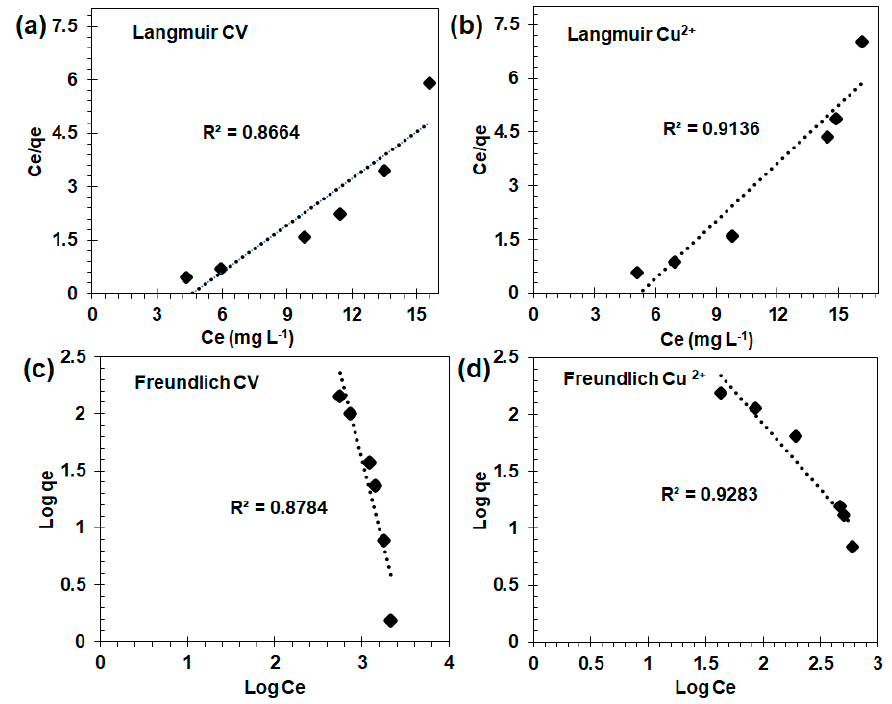
Figure 7. ( a , b ) Langmuir and ( c , d ) Freundlich adsorption isotherms of CV molecules and Cu 2+ ions onto SF:SS (4:1) composite. Table 3. The parameters of Langmuir and Freundlich isotherms for the adsorption of CV. Isotherm